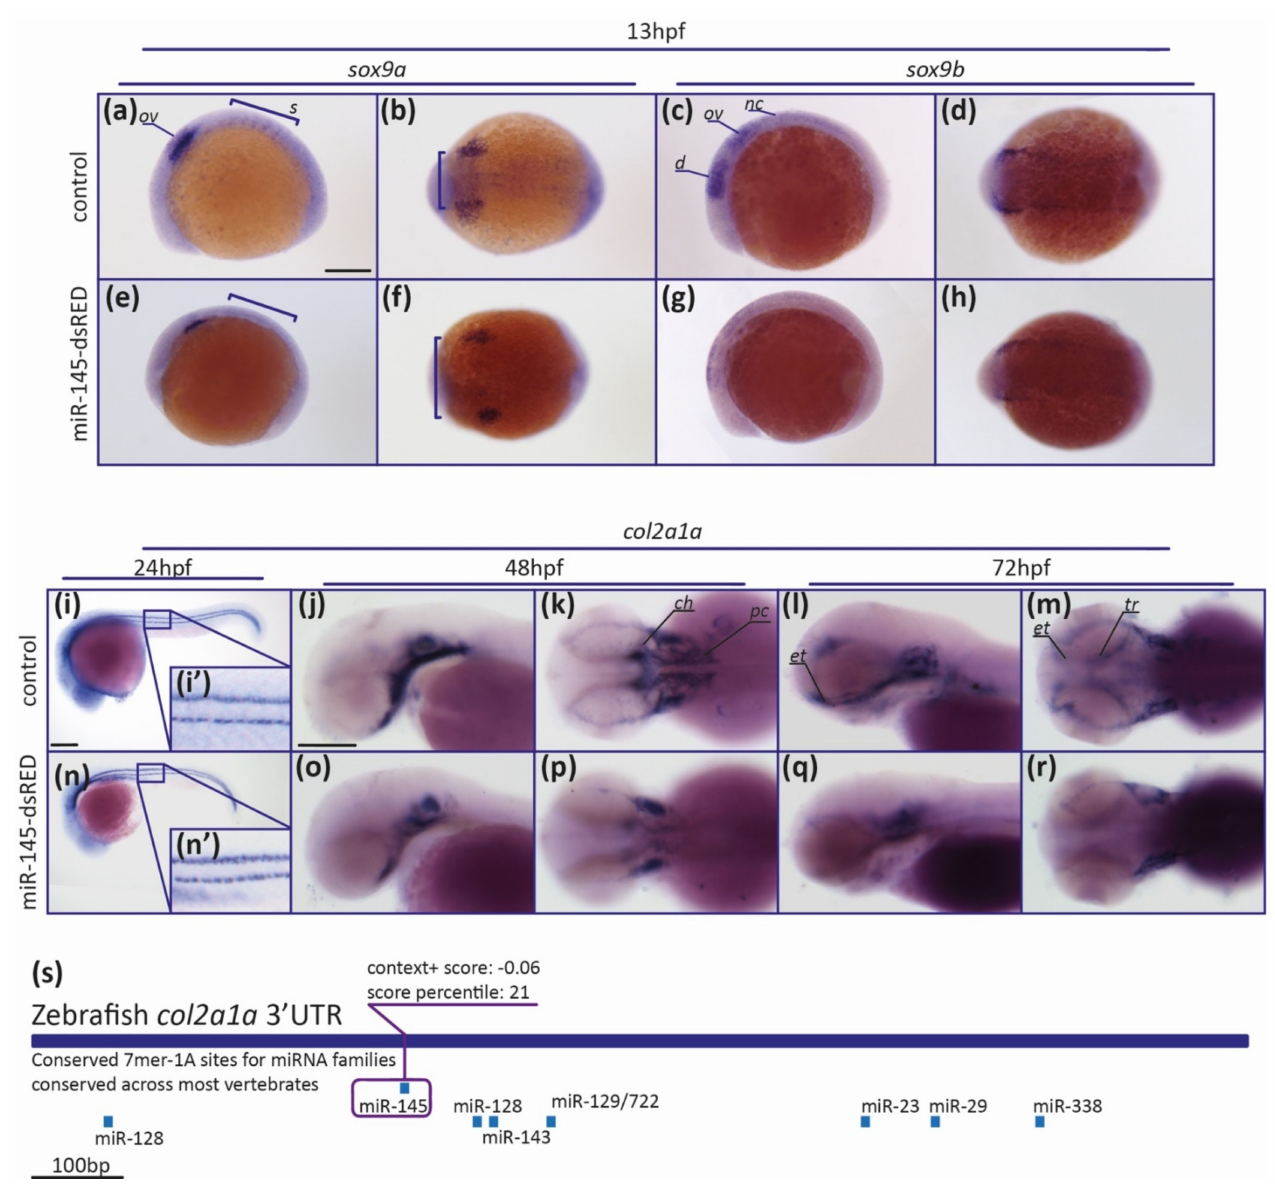
Figure 7. MiR-145 upregulation affects the expression of NCC marker genes. ( a – h ) Whole-mount in situ hybridization of sox9a ( a , b , e , f ) and sox9b ( c , d , g , h ) performed on 13 hpf miR-145-dsRED microinjected embryos. Lateral views are dorsal to top ( a , e , c , g ); dorsal views are anterior to left ( b , f , d , h ). In ( a ) ov: otic vesicle; s: somites. In ( c ) d: diencephalon; ov: otic vesicle; nc: neural crest. Scale bar represents 200 µ m in ( a ) for ( a – h ). ( i – r ) Whole-mount in situ hybridization of col2a1a (ENSDARG00000069093) in miR-145-dsRED microinjected specimens at 24 hpf ( i , n ), 48 hpf ( j , k , o , p ), and 72 hpf ( l , m , q , r ). Lateral and dorsal views are head to left. In ( k ) ch: ceratohyal; pc: parachordals. In ( l , m ) et: ethmoid plate; tr: trabeculae. ( s ) Schematic representation of col2a1a 3 (cid:48) UTR. Putative miRNA binding sites are shown below each region. MiR-145 site is enclosed in a purple box, with its respective context+ score. Scale bars represent 200 µ m in ( i ) for ( i , n ); and in ( j ) for ( j – m ) and ( o – r